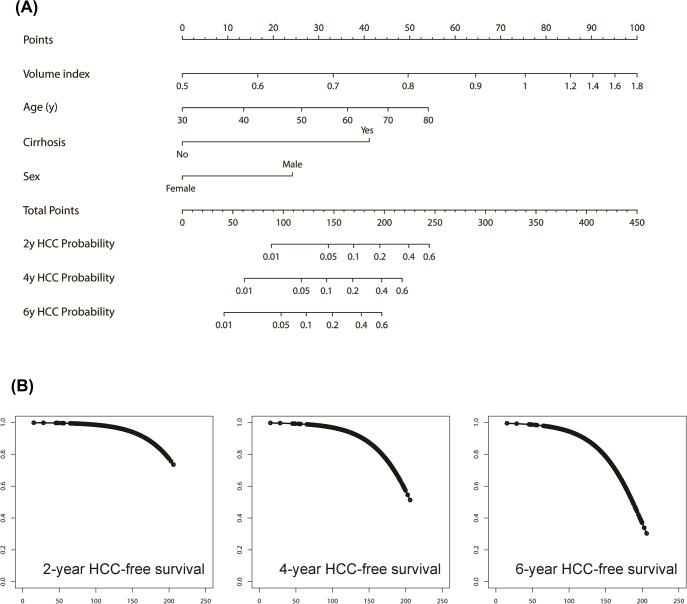
Development of HCC prediction model by Cox analysis.(A) Nomogram for predicting future HCC development based on Cox independent predictors. Points of each parameters (Points axis) are summed to get the total points (Total Points axis), which are then transformed to get the corresponding 2, 4 and 6-yr predicted probability for HCC. (B) Predictiveness curves of nomogram-based volume score (x-axis) plotted against predicted probability of HCC-free survival (Y-axis).